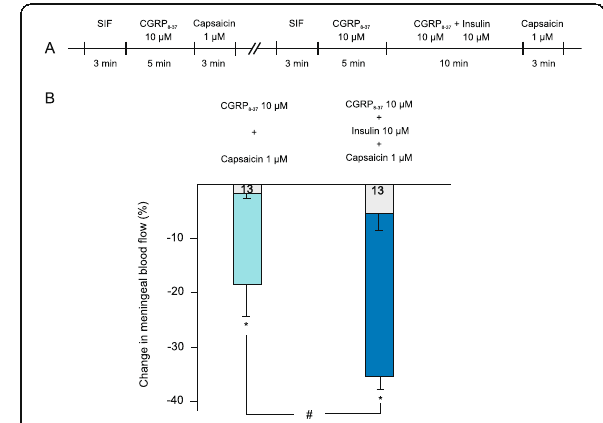
Fig. 4 Changes in meningeal blood flow induced by topical application of capsaicin at high concentration. (A) Flowchart summarizing the experimental protocol. (B) Blood flow reducing effect of capsaicin (1 μ M for 3 min) after preapplication of CGRP 8 – 37 (10 μ M for 5 min) or CGRP 8 – 37 (10 μ M for 5 min) followed by a mixture of CGRP 8 – 37 and insulin (both at 10 μ M for 10 min). The light grey bars indicate the effect of CGRP 8 – 37 and the combination of CGRP 8 – 37 and insulin, respectively. Coloured bars indicate the capsaicin-induced changes in blood flow. The number of measurements is indicated in the bars. *: statistically different from the basal flow. #: statistically different from the effect without insulin